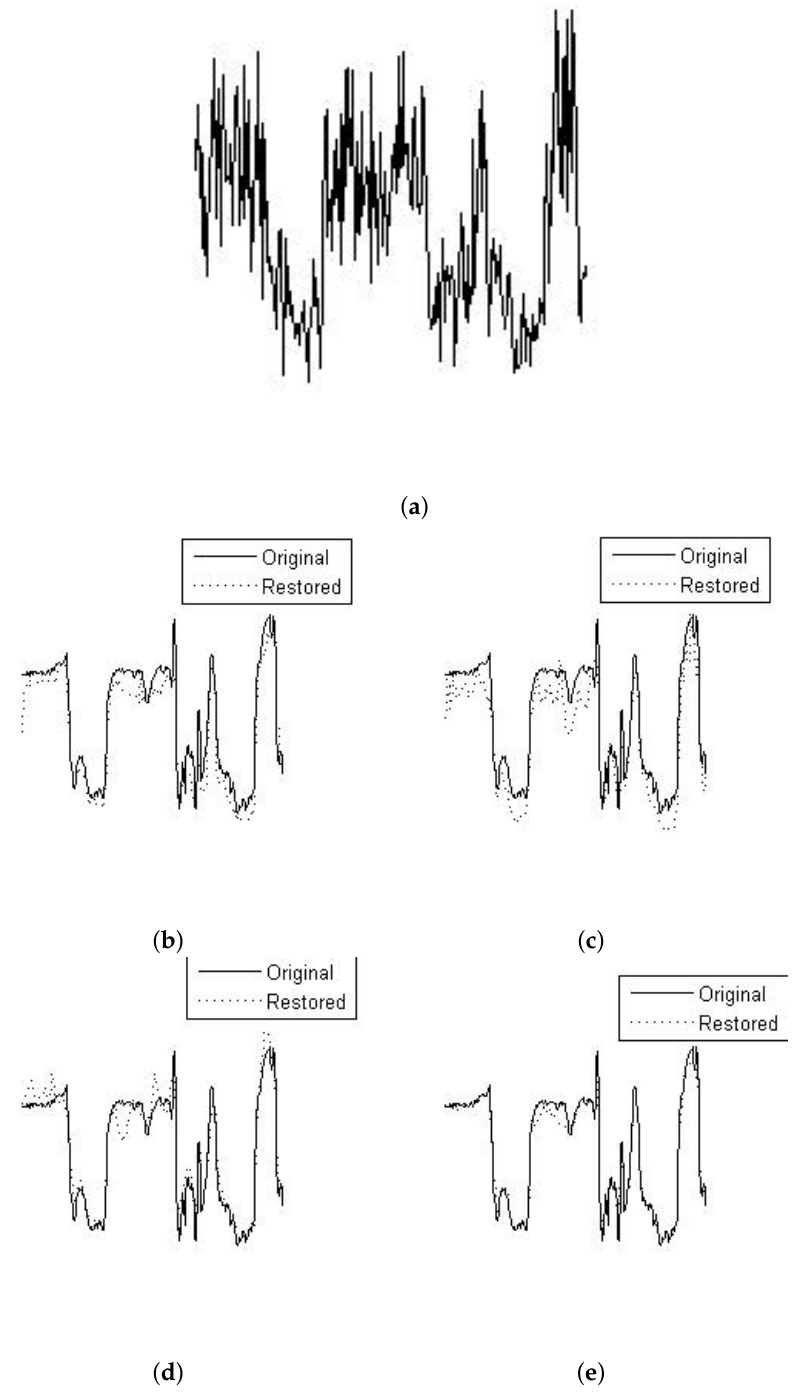
Figure 9. Slice of Boats (the 5th column) and their corresponding denoising results under the noise level L = 20: ( a ) Noise image. ( b ) CONVEX. ( c ) OGSTVD. ( d ) M-TGV. ( e )